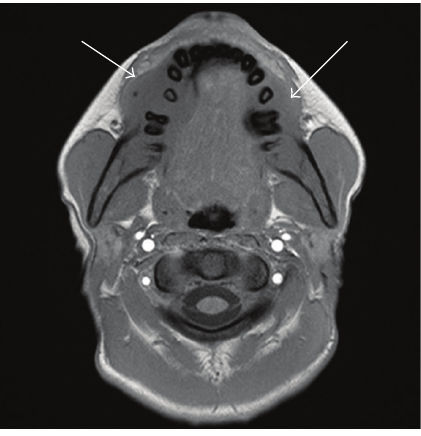
Figure 2: Axial T1 and T1 FS after contrast, demonstrating isoin- tense, enhancing mandibular masses, cortical erosion, and adjacent soft tissue mass.